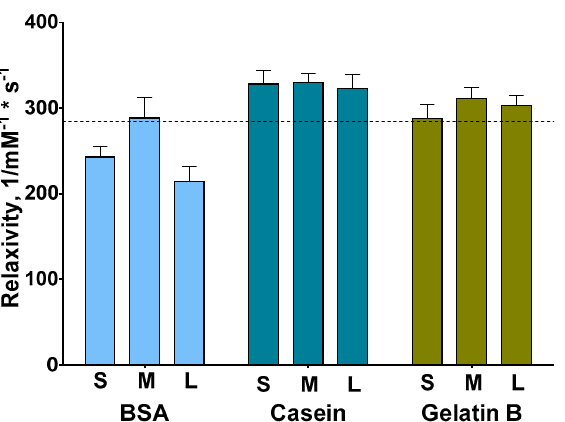
Figure 2. Relaxivity of conjugates with di ff erent sizes and coating types, n = 5, mean ± SD. Letters “S”, “M”, and “L” indicate “small”, “medium”, and “large” nanoclusters, respectively; the dashed line indicates the relaxivity of the parent Fe@C-NH 2 (285 1 / mM − 1 × s − 1 ). Conjugate Fe@C-NH 2 / Gelatin B / Str with highest relaxivity was excluded when mean relaxivity values were calculated.